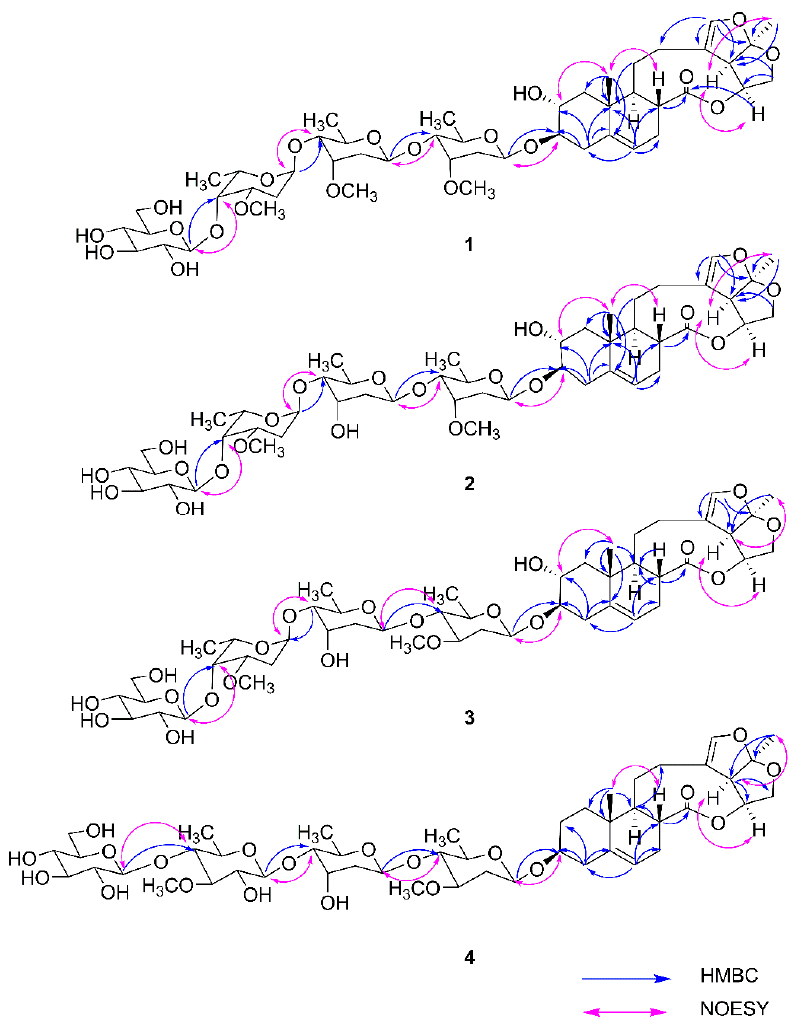
Figure 2. Key HMBC and NOESY correlations of compounds 1 – 4 .